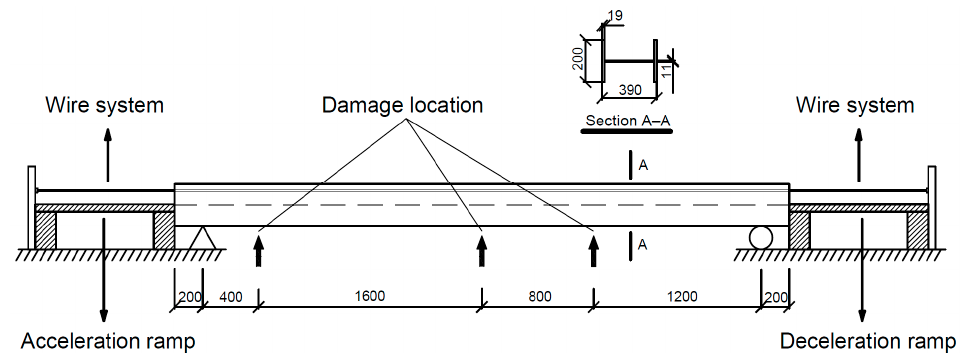
Figure 9. Simply supported bridge model.